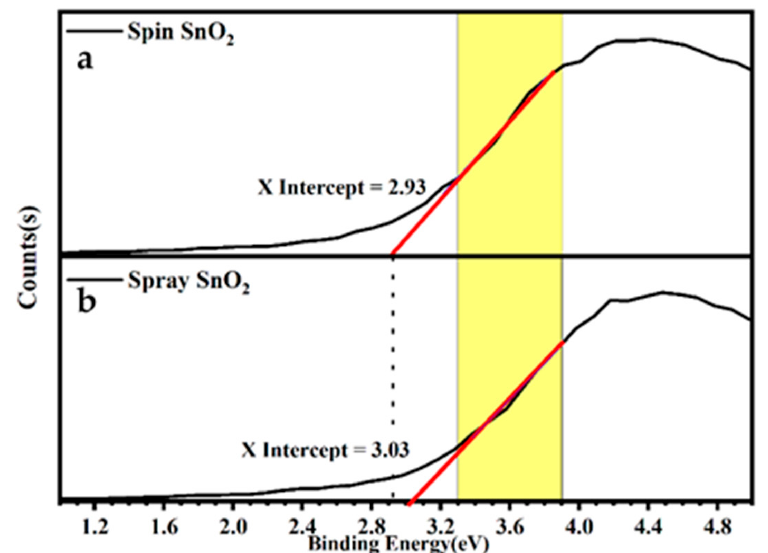
Figure 5. XPS valence band spectrum of spin-coated ( a ) and sprayed ( b ) SnO 2 films. Based on spin-coating and spraying methods, we prepared perovskite cells with device structures of FTO/SnO 2 /PVSK/Spiro/Au and compared the performance of the cells prepared by the two methods through light I–V tests. The effective area of the cell was 0.0975 cm 2 . The whole process is exactly the same except for the SnO 2 preparation. Figure 6 shows the J–V and EQE curves of the two cells with the highest efficiency among the two types of cells. Figure 7 shows the box-plot of light I–V parameters of the two types of perovskite cells. Cells based on sprayed SnO 2 film have larger open circuit voltage (V OC ), higher fill factor (FF), and lower series resistance, which is mainly attributed to the higher carrier concentration of SnO 2 . High carrier concentration means that the Fermi level is closer to the conduction band minimum, and the chemical potential between the electron and hole transport layer is higher. Therefore, the cells based on sprayed SnO 2 have higher V OC and FF. It can be seen that the short-circuit current density (J SC ) of cells based on spin-coated SnO 2 were slightly higher from Figure 6 (300–500 nm) and Figure 7d. It might be attributed to the larger surface roughness for the spin-coated SnO 2 film, resulting in a light trapping effect and increasing the absorption of light by the perovskite film. Because the absorption length for the 300–500 nm light is very short (~55 nm), the rough surface usually has an obvious effect in this range which leads to the EQE improvement. The highest efficiency of the perovskite cell prepared based on the spraying method of SnO 2 is 0.8% higher than that of the spin-coating method, and the average efficiency is about 1.1% higher due to the lower roughness and higher carrier concentration of SnO 2 . The ultrasonic spraying method is very suitable for preparing the SnO 2 ETL on a large-area